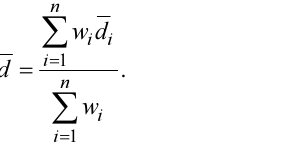
Fig. 9. Percentage distribution of particle sizes by mass in AC 16 PD 70/100 In terms of the granulometric composition of AC 16 PD 70/100 asphalt concrete, the percentage distribution by mass of particles in diameter D < 1 mm amounts to ~34% (Fig. 9). This paper focuses on asphalt concrete type AC 16 PD 70/100, which is widely used for road structures. One of the most important parameters that characterize asphalt concrete is granular particle percen- tage distribution by size given in Figure 9. Particle size varies form 0.075 mm to 16 mm. In this paper, the inner model structure was created using the average particle size approach, which is discussed in Mo et al. (2008) paper, where particles less than 1 mm in size are not ta- ken in to account; for the average particle size calcula- tion, the average particle size is: